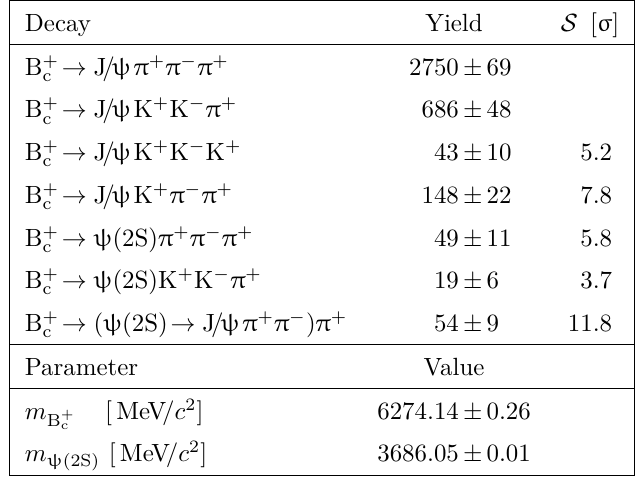
Table 1 . Parameters of interest from the simultaneous unbinned extended maximum-likelihood fit. The uncertainties are statistical only. For previously unobserved decay modes, the last column shows the statistical significance estimated using pseudoexperiments in units of standard